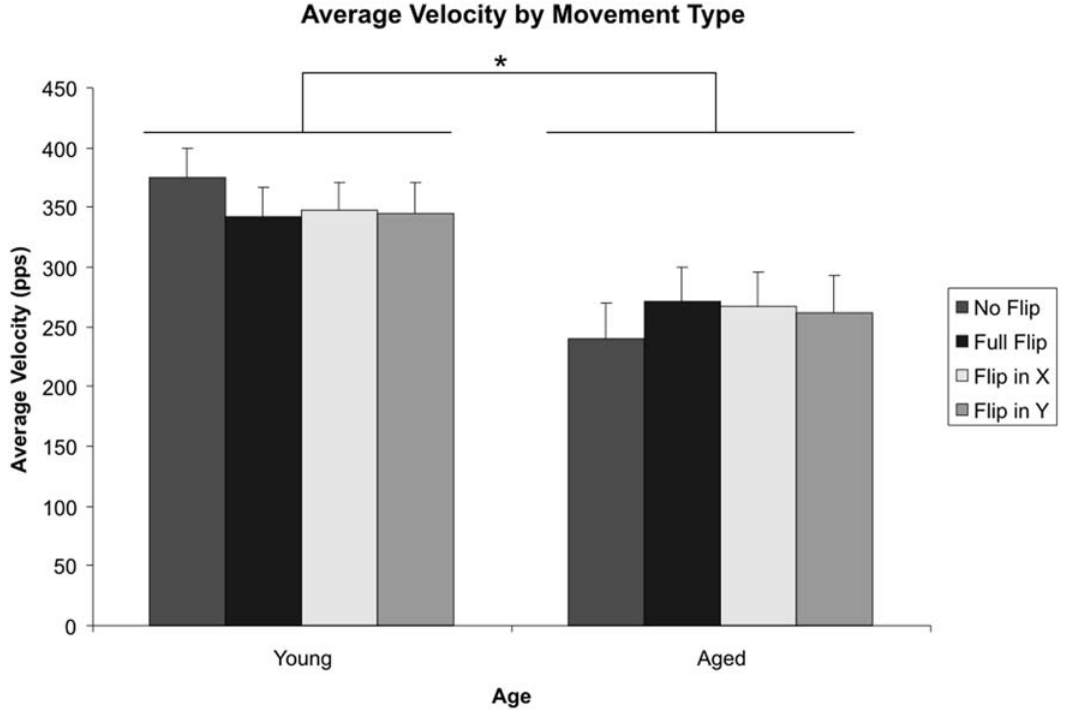
Figure 6. Average Trial Velocity. Aged participants had an overall lower mean velocity. However, there was no Age x Visuomotor interaction present. Error bars represent the standard error of the mean. *p , 0.05 indicates a significant difference.